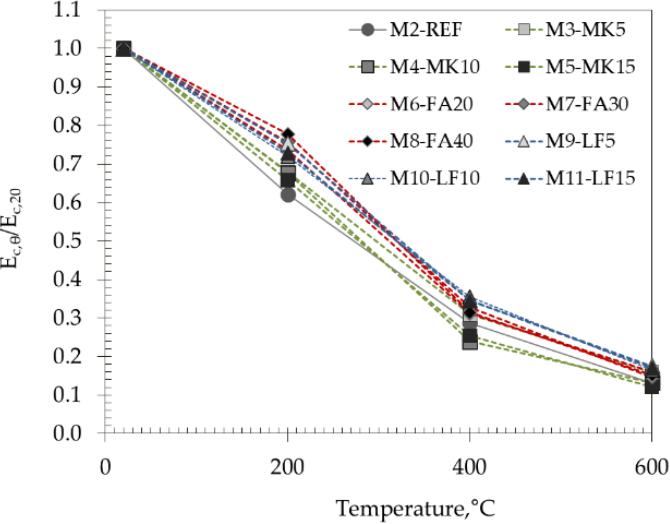
Figure 13. Relative values of modulus of elasticity with increasing temperature.